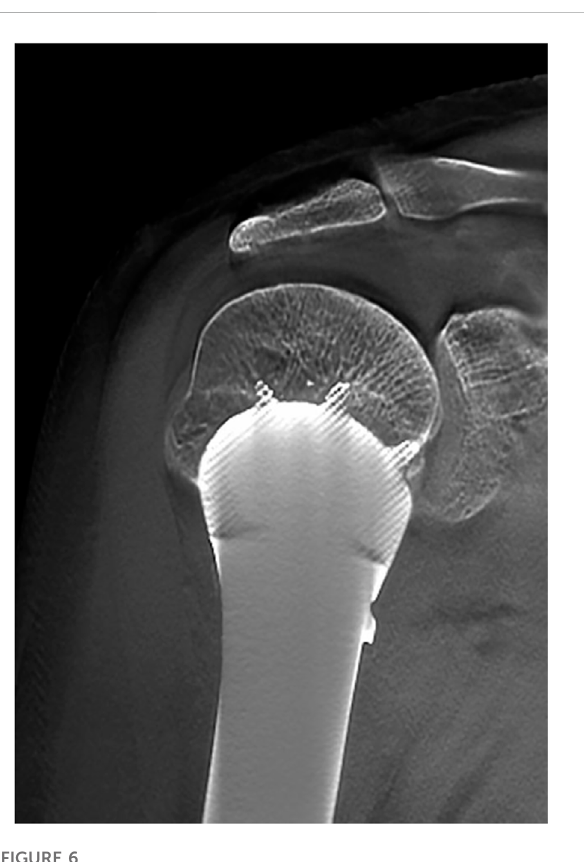
FIGURE 6 T-SMART showed preliminary osseointegration 6 months after